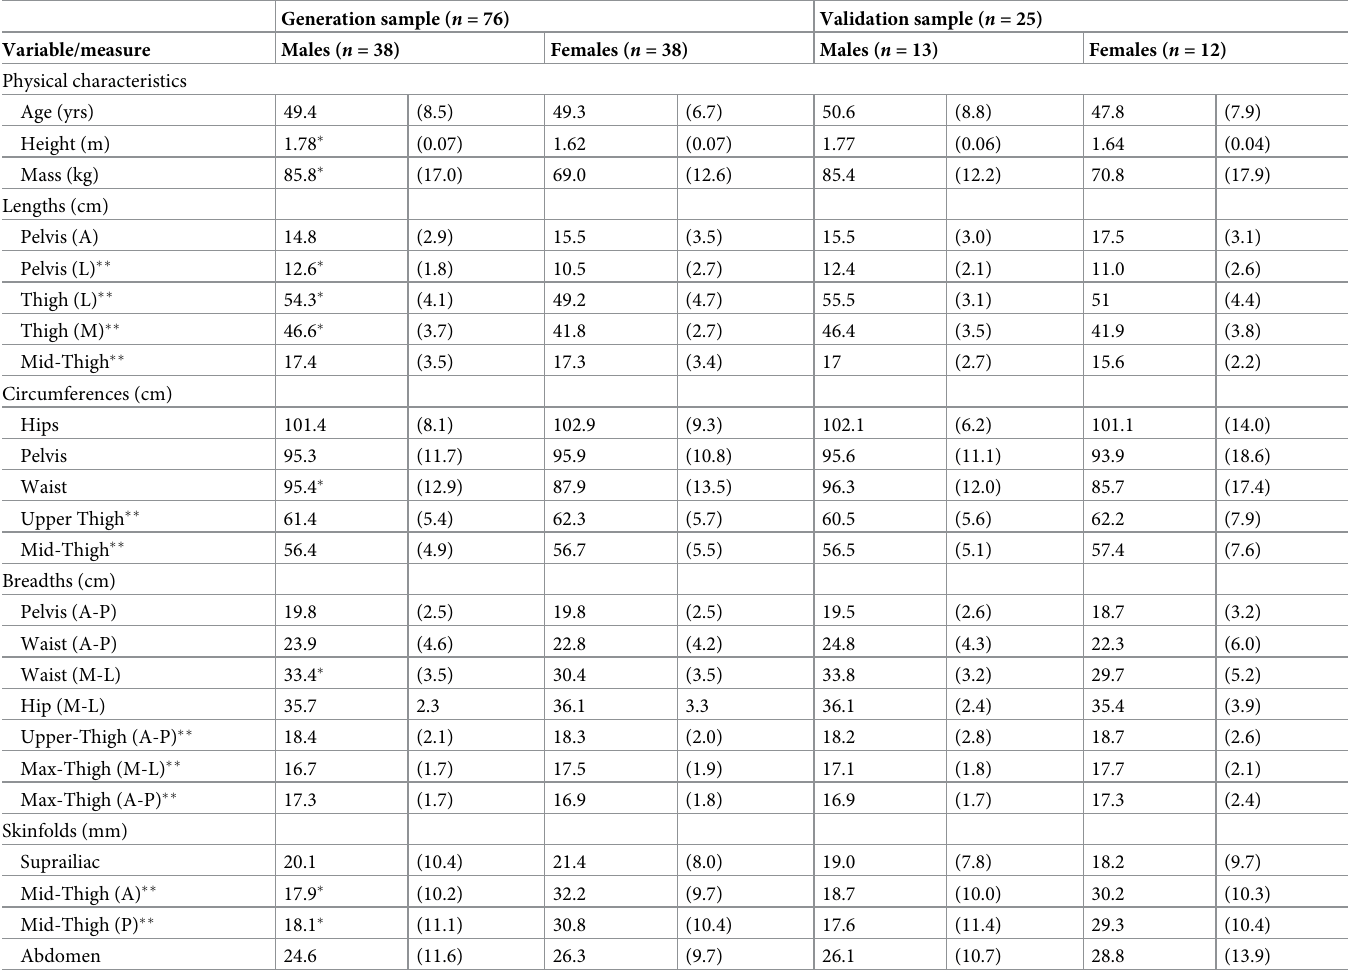
Table 2. Mean ( ± SD) general physical characteristics and anthropometric measures for older (36–65 years) male and female participants in both generation and validation